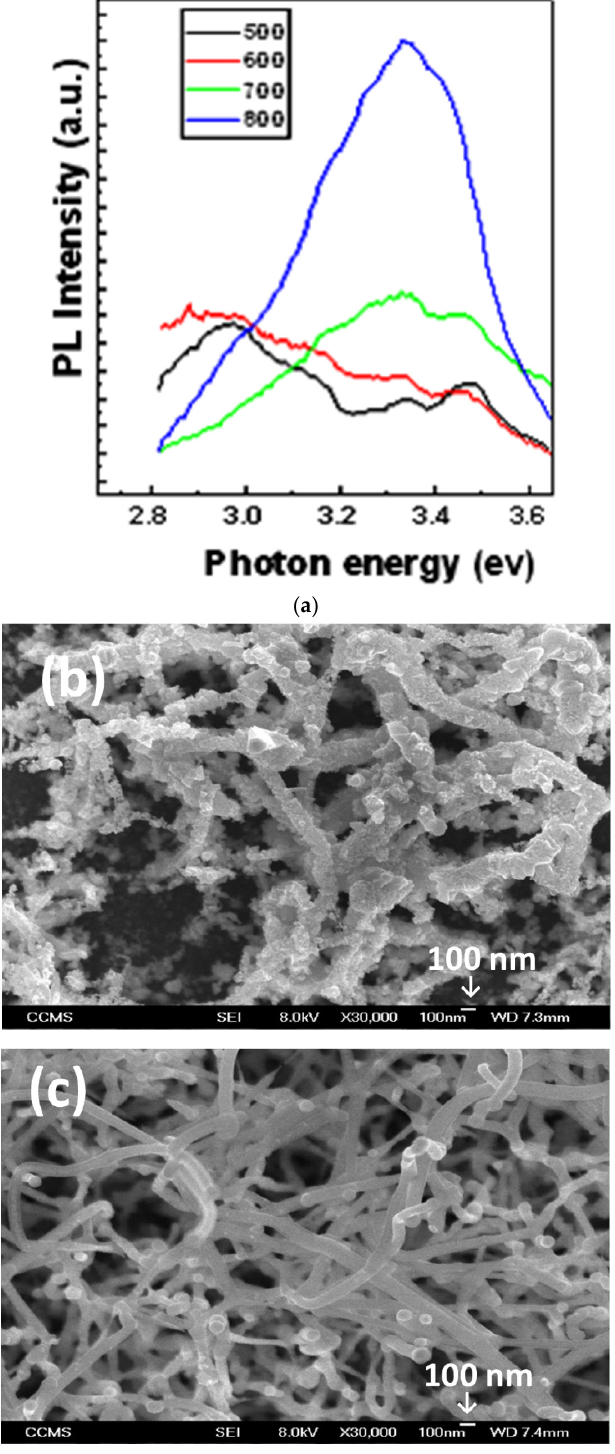
Figure 2. ( a ) Photoluminescence spectra (RT, 325 nm excitation) of a Co-GaN NW/Si sample with dose concentration 4 × 10 16 cm − 2 and annealed at different temperatures of 500, 600, 700, and 800 °C; SEM images from the Co-GaN NW/Si sample annealed at temperatures of ( b ) 800 °C and ( c ) 700